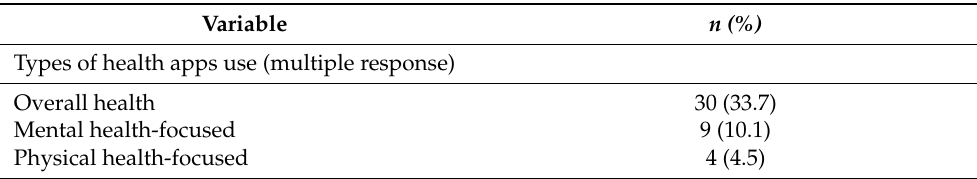
Table 4. Status of health Apps use of Korean workers ( n =